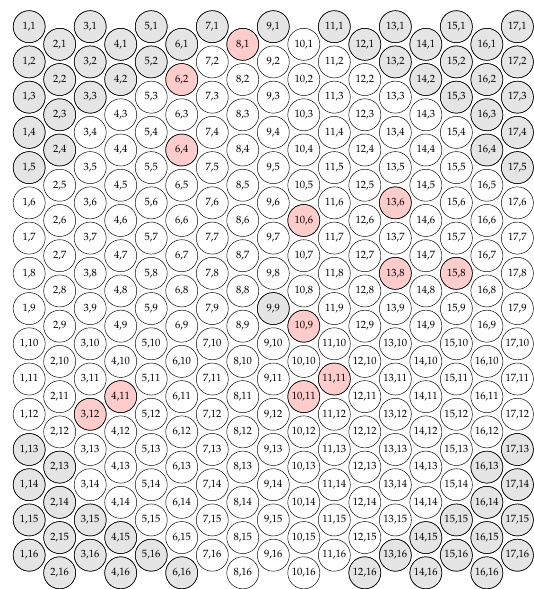
Figure 4. Position of promising samples due to high ∆ T value (red background) from composition range Pt 3 Al a Mn b Ce c on slate library plate 1. Wells with gray background are not present on the plate.